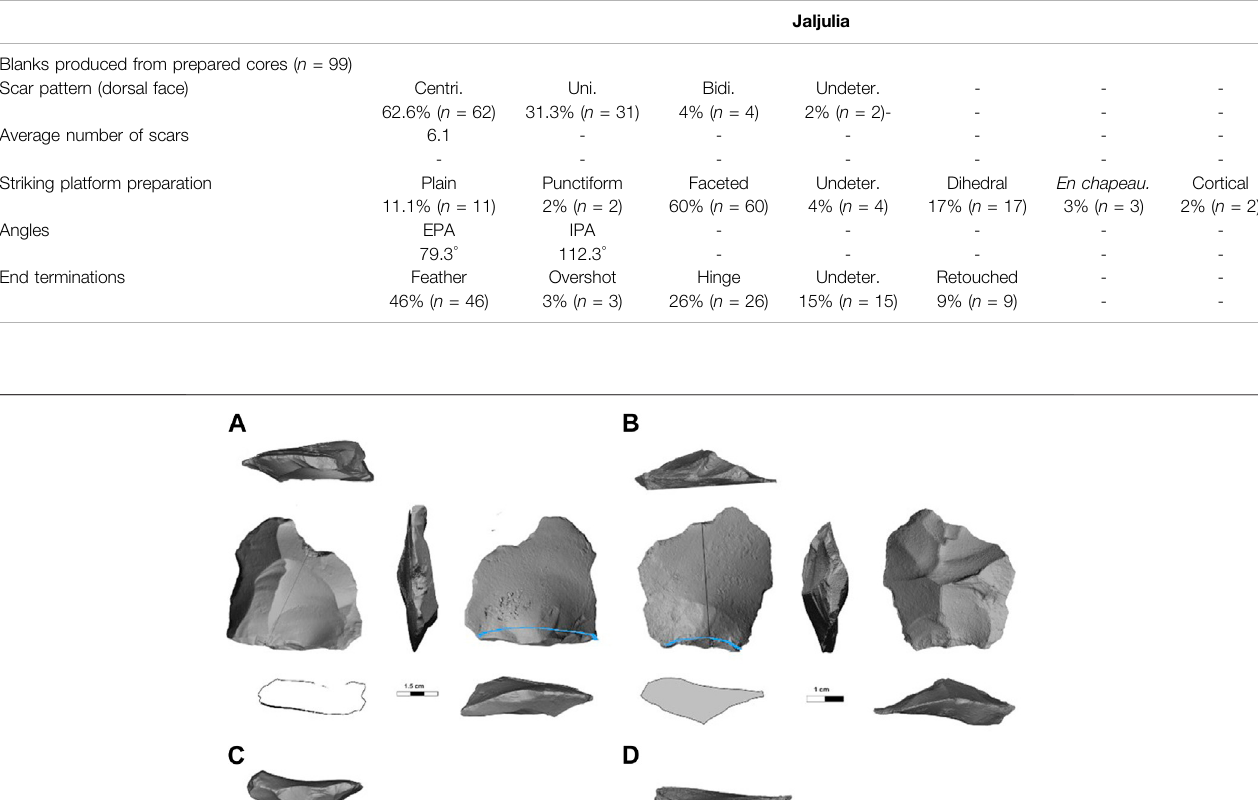
Frontiers in Earth Science |